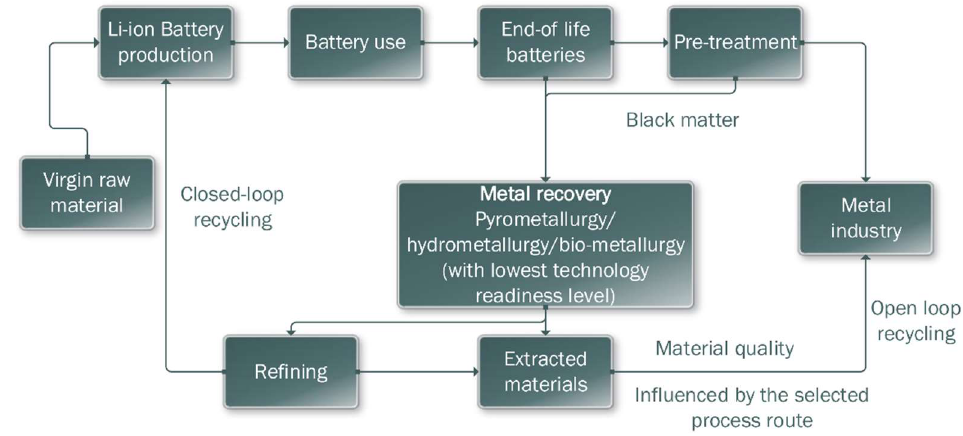
Figure 1. Value chain of LIBs, redrawn from [16].